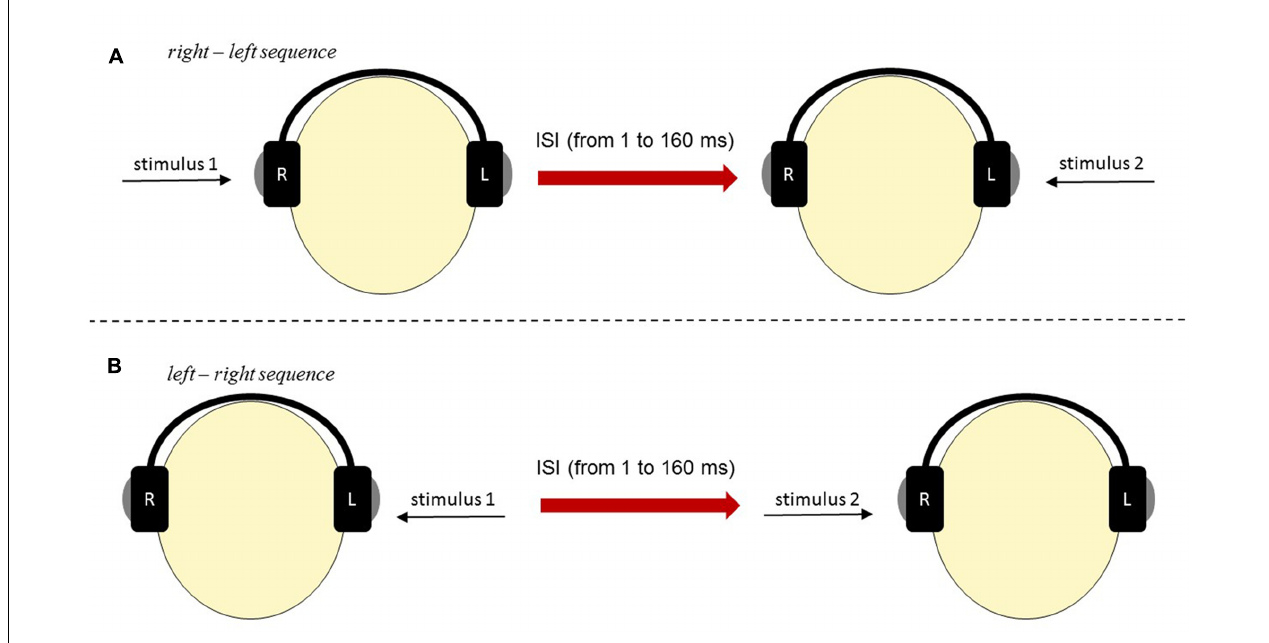
FIGURE 2 | The scheme of stimuli presentation in TOJ Task: (A) ‘right–left’ sequence and (B) ‘left– right’